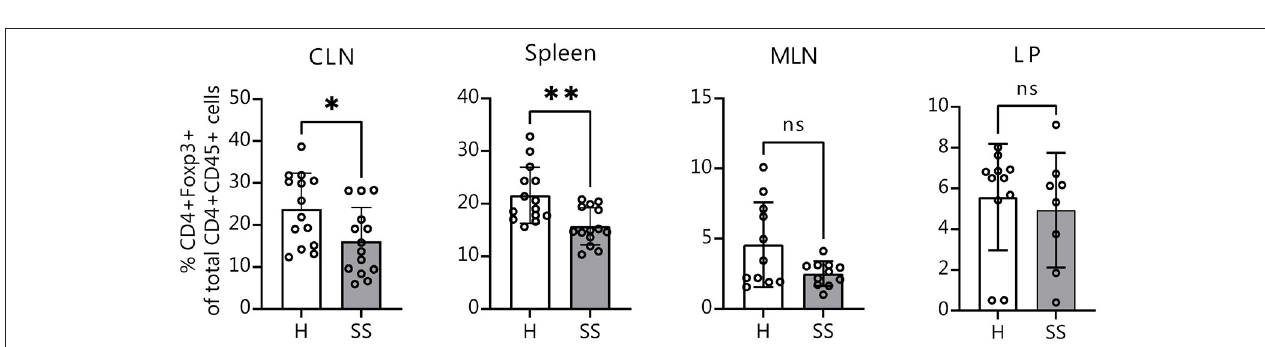
FIGURE 5 | Offspring of SS-humanized mice also have fewer CD4 + FOXP3 + cells in the CLN as well as spleen, demonstrating vertical transmission. Cumulative flow cytometry data showing percentage of CD4 + FOXP3 + cells from CLN, spleen, MLN, and lamina propria of 8-week-old offspring of mice gavaged with patient stools. CLN, cervical draining lymph nodes; MLN, mesenchymal lymph nodes; LP, lamina propria. Statistical significance was assessed using non-parametric Mann-Whitney U-tests. * P ≤ 0.05, ** P ≤ 0.01, ns, not significant.